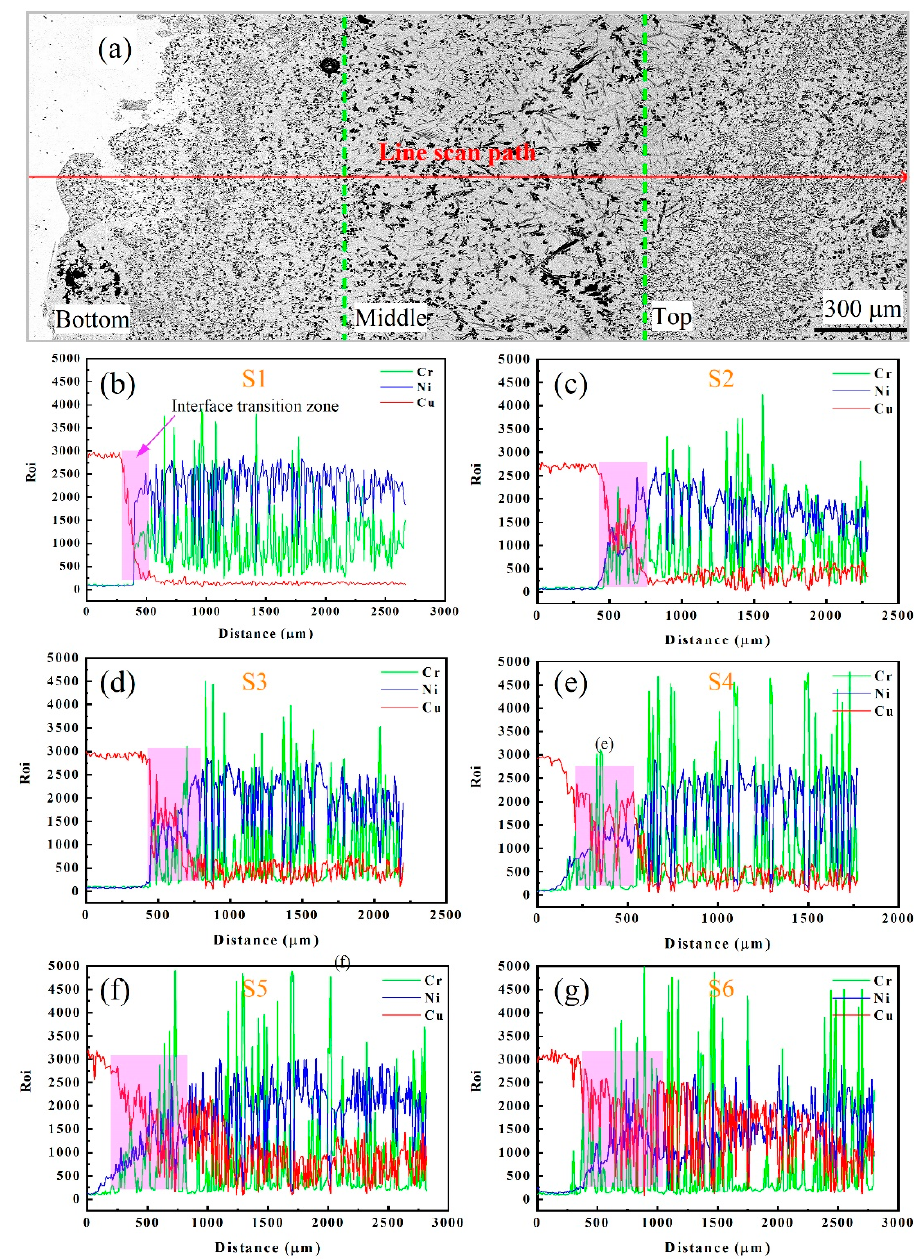
Figure 10. EDS line scan results of S1–S6 along the direction from the copper substrate to the coating: ( a ) SEM micrograph from copper substrate to the top of the coating, ( b – g ) the EDS line scan results along the copper substrate to the top of the coating (S1–S6).